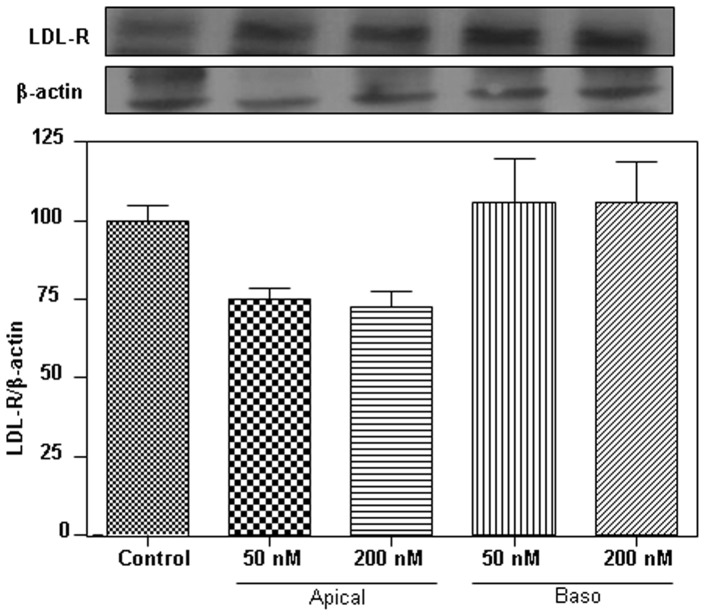
Effects of the administration of PYY (1–36) to the apical or basolateral medium on the protein expression of LDL-receptor (LDL-R).Caco-2/15 cells were cultured for 24 h in MEM as described in the legend of Figure 2. Western blot was used to analyse the protein expression of LDL-R. Data represented means ± SD for n = 3 separate experiments in each group and are reported as % of control values representing 100%.